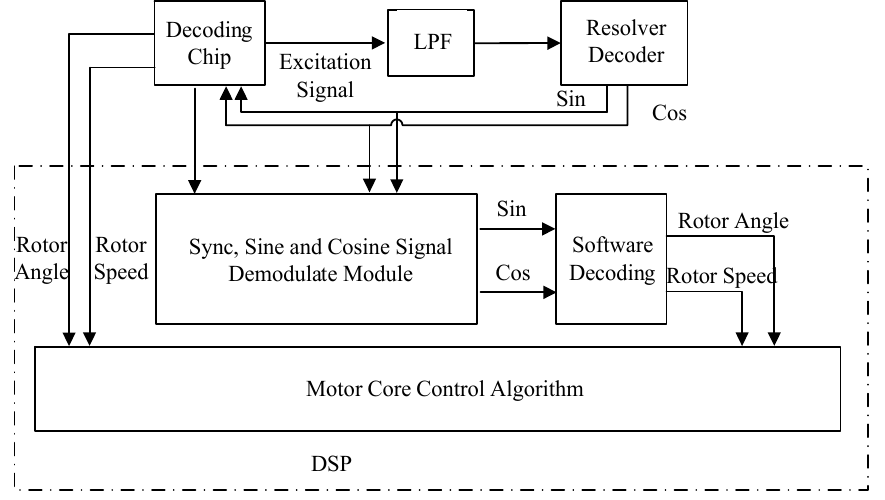
Figure 2. Schematic diagram of the resolver position redundancy decoding scheme.